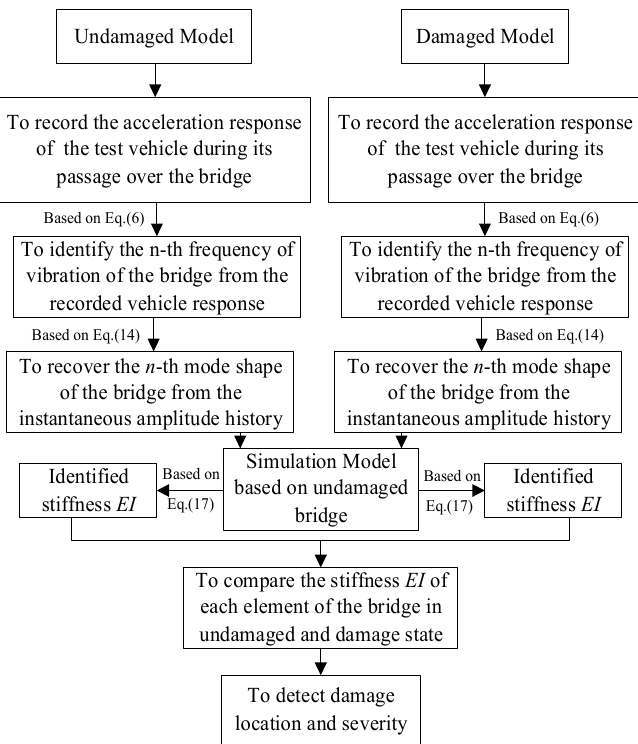
Figure 2. Flowchart of the frequency domain method.